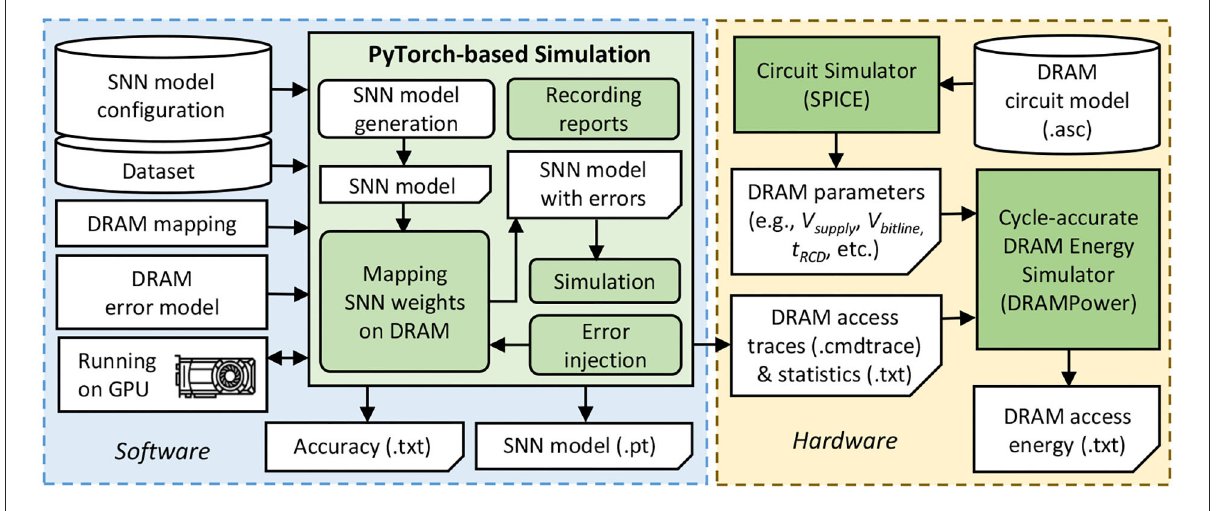
FIGURE10 Our experimental setup and tools